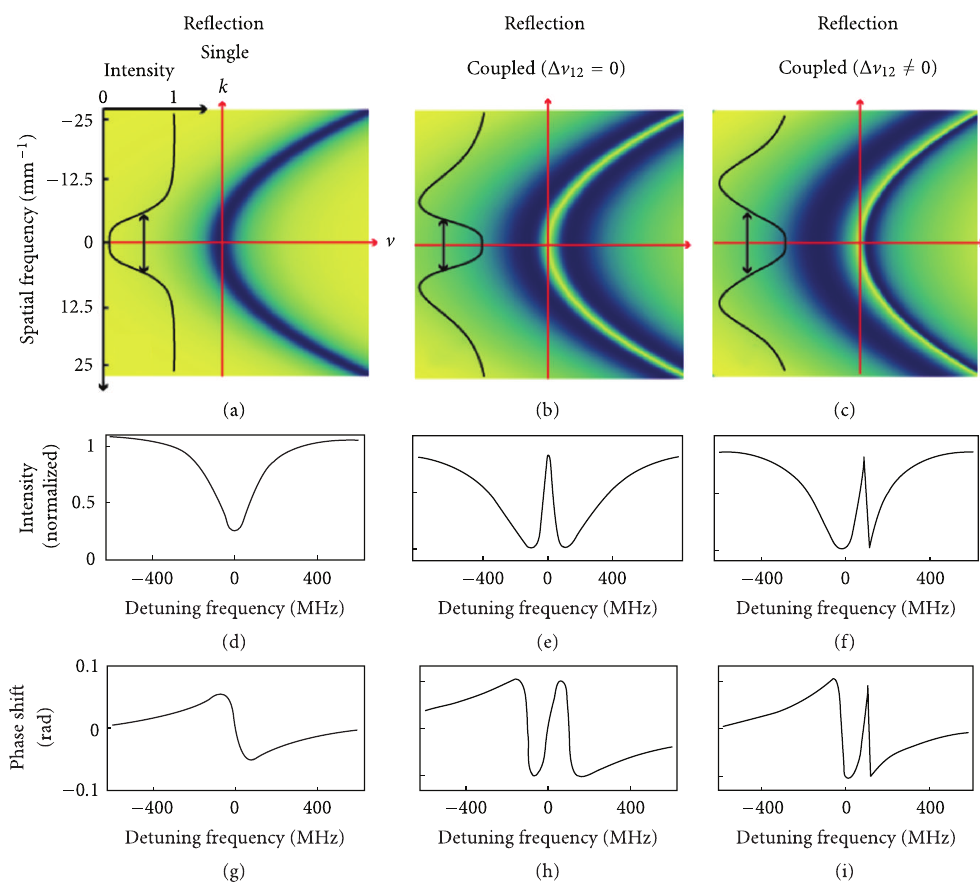
Figure 2: (a) − (c) Calculated intensity transfer functions | T ( k , ν ) | 2 for (a) a single image resonator, (b) coupled image resonator with Δ ν = 0, and (c) coupled image resonator with Δ ν / = 0. The black solid curves along the k -axis in Figures (a)–(c) are the k -space cross- 12 12 sections | T ( k ,0) | 2 . (d) − (f) ν -space cross-sections | T (0, ν ) | 2 . (g) − (i) Calculated phase shift as a function of the detuning frequency. Note that, in (a), the reflectances of the mirrors were R 1 = 0 . 9 and R 2 = 0 . 7, and the cavity length was L 1 = 10cm; in (b) and (c), the reflectances were R 1 = 0 . 5, R 2 = 0 . 9, and R 3 = 0 . 99, and the cavity lengths were L 1 = 5 cm and L 2 = 10cm, respectively. The k -space cavity bandwidths in (a), (b), and (c) were Δ k = 10 . 1 mm − 1 , Δ k = 9 . 8 mm − 1 , and Δ k = 13 . 3mm − 1 , respectively, as indicated by the solid black double-arrow